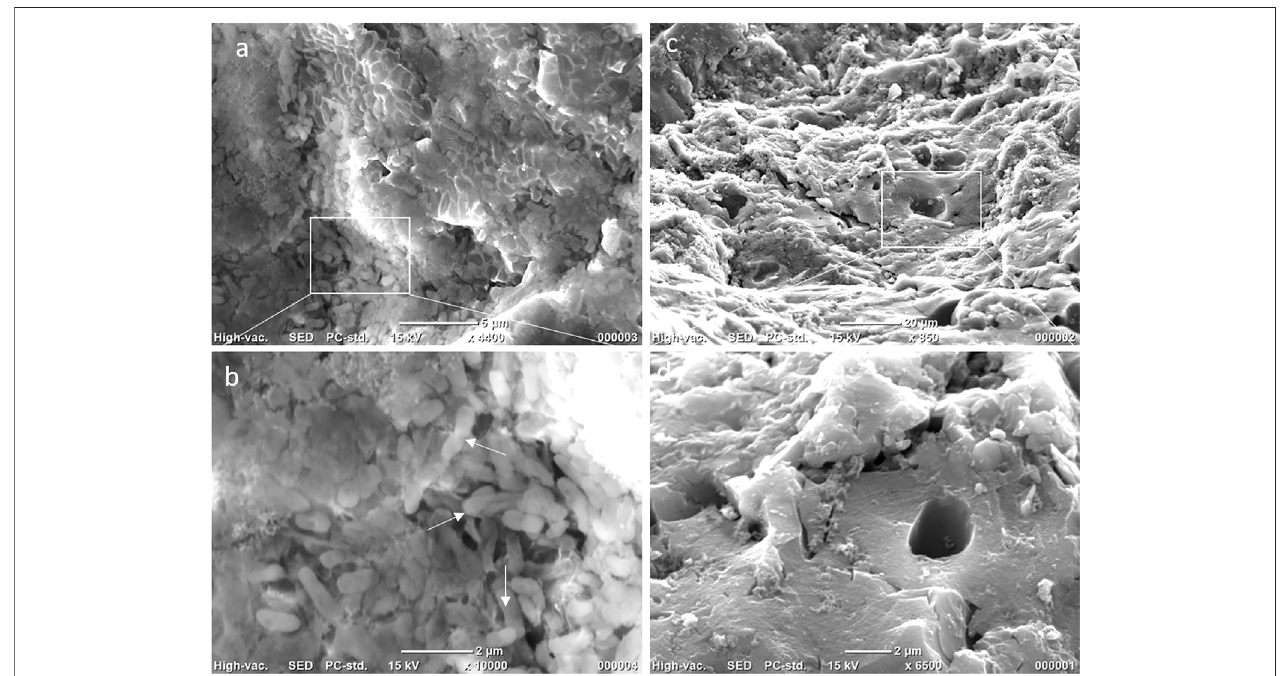
FIGURE9 | (A) Scanning electron microscopyimage ofbiochar particleswith amixed culture, and (B) enlarged image ofthe whiterectangle area. (C) No-bacteria reference biochar particle and (D) zoomed in on the area in the white box. White arrows point to representative bacterial cells.